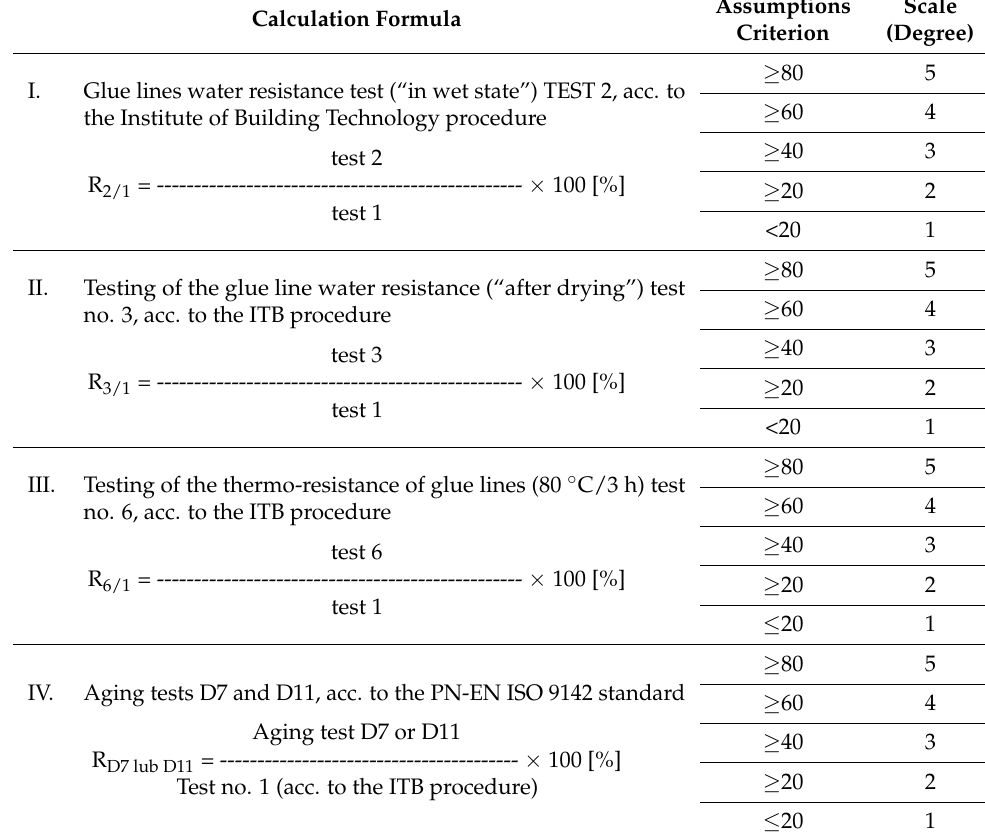
Table 3. Rating scale based on the relative strength and resistance of glue lines. Calculation Formula